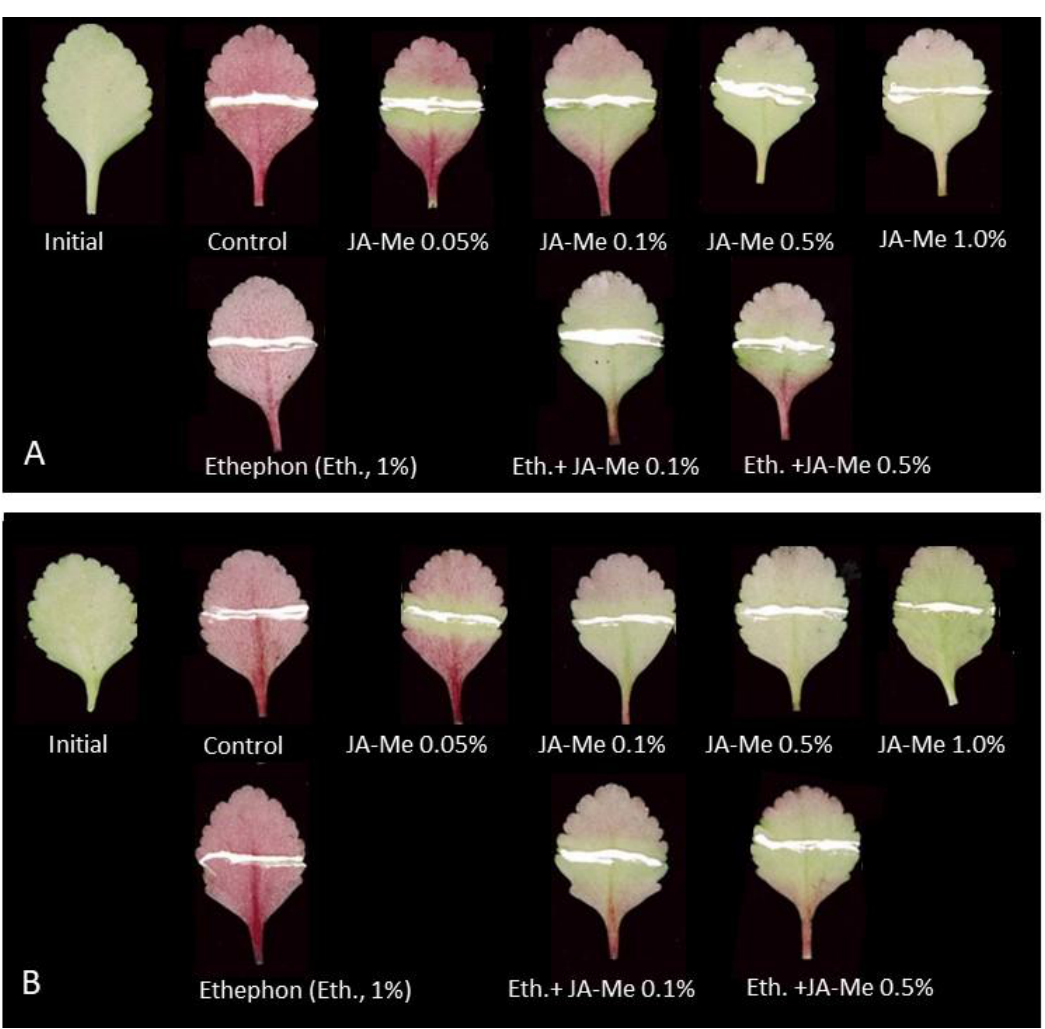
Figure 4. Effect of JA-Me and ethephon applied separately and simultaneously with JA-Me on the abaxial side of detached K. blossfeldiana leaves and kept in an inverted position under natural light for 4 days without water ( A ) and on filter paper moistened with water ( B ) on anthocyanin accumulation. When detached leaves were soaked in JA-Me solution for 1 h and then kept in the inverted position for 4 days in natural light conditions (Figure 5), a significant inhibition of anthocyanin accumulation was observed in a dose-response manner.